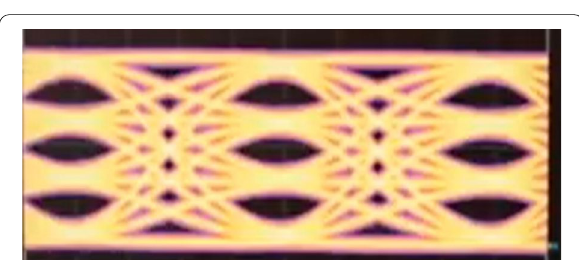
the dielectric layer coated only SiN x , while in device B, it coated Al 2 O 3 ALD and SiN x together. SiN x , polyim-